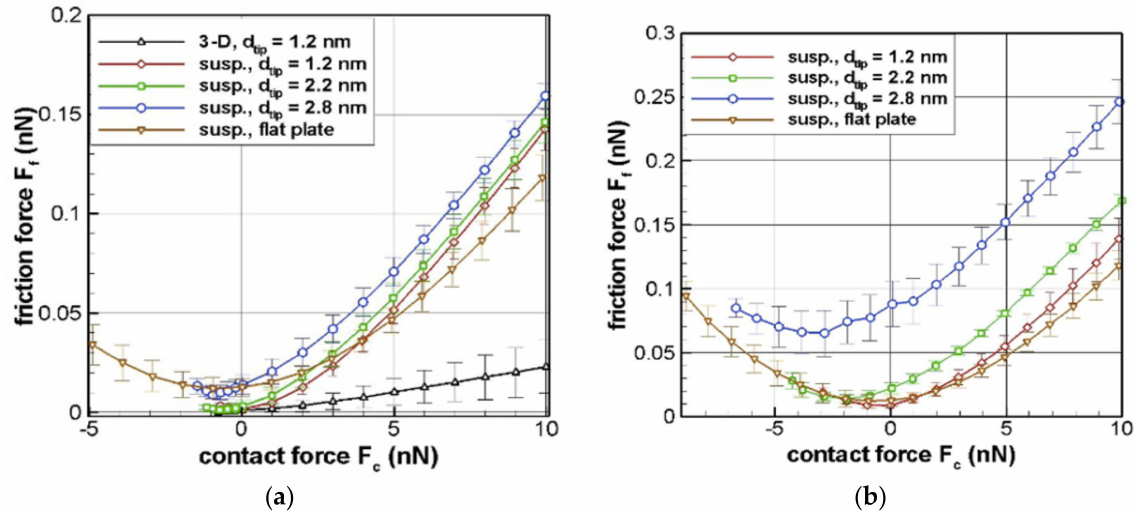
Figure 6. Atomistic simulation result of frictional force versus full range sweep of contact force for suspended graphene interlayer adhesion: ( a ) for empirical interlayer adhesion at a constant Van der Waal’s force and ( b ) for empirical interlayer adhesion when Van der Waal’s forces are increased by 4 times that of (a). (Here, susp. indicates suspended graphene whereas 3-D indicates isotropic graphite [34].